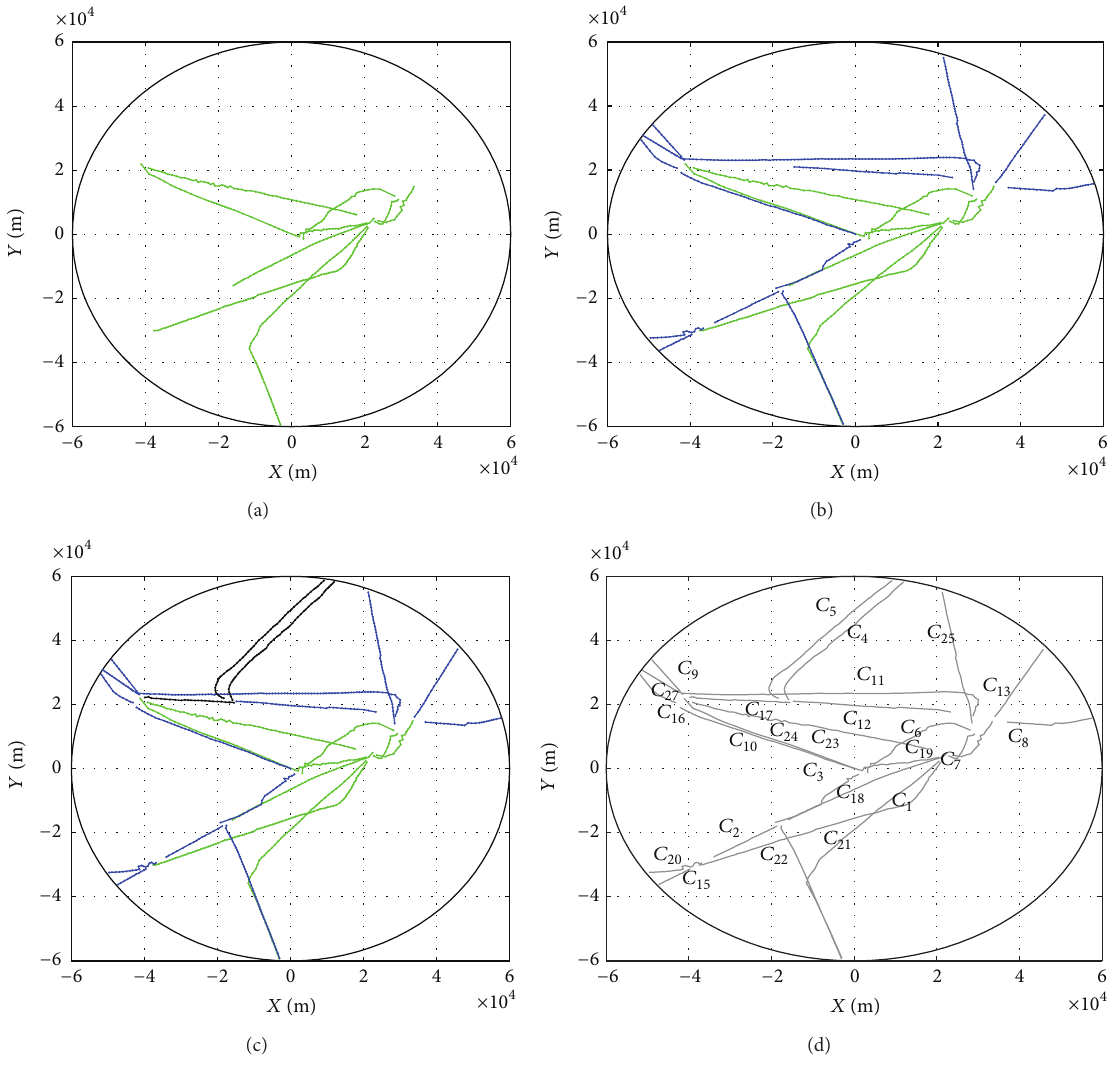
Figure 6: The evolution of clustering process for departure